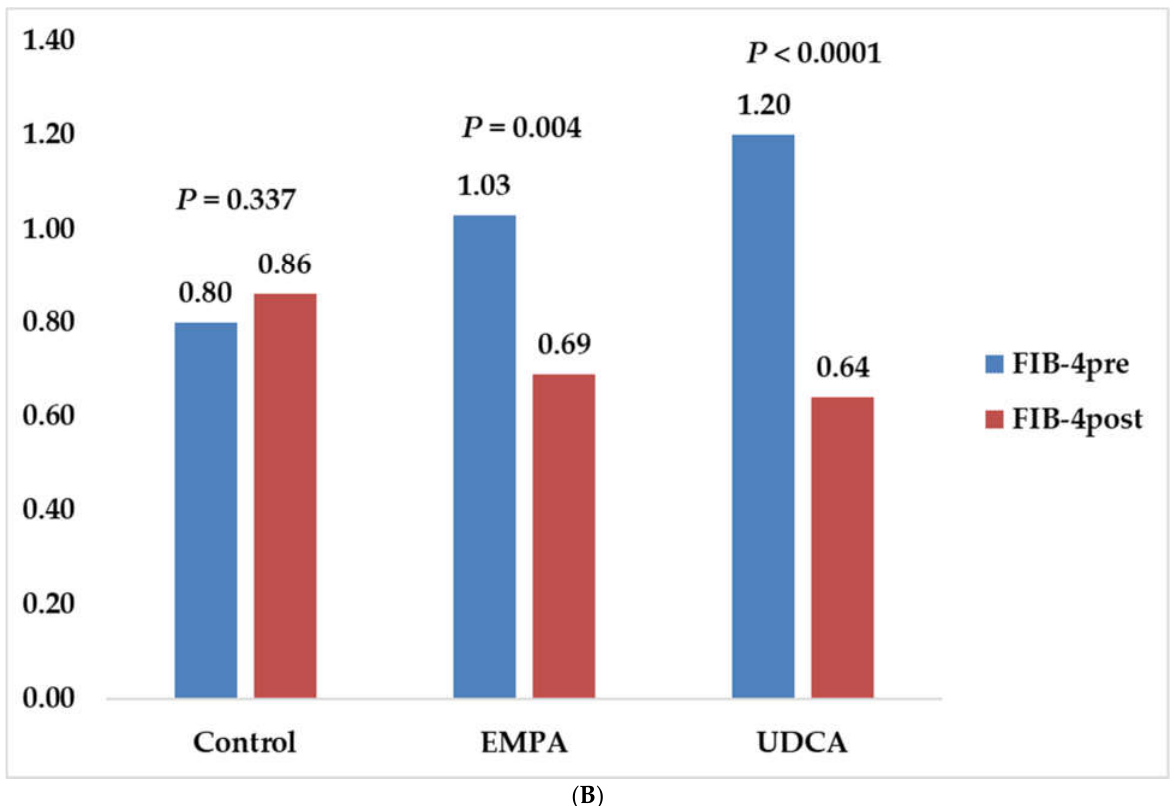
Figure 3. Changes in fibrosis indices in study groups after six months. ( A ) Changes in non-alcoholic fatty liver score. ( B ) Changes in the FIB-4 index. Table 3. Correlation study between changes in LFC (%) and changes in selected measured parameters after six months of treatment in study